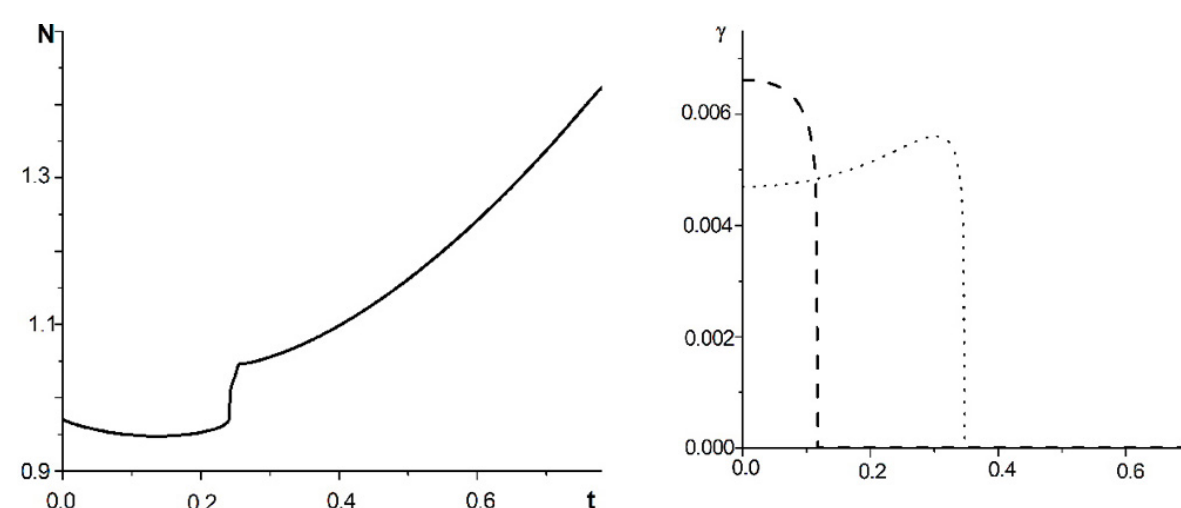
Fig. 9. Growth rates normalized to ω Hfix versus dimensionless time for two wave packets launched at the center of the model cavity with k r = 0 , k θ = 0 and different values of k ϕ . Dashed line corresponds to k ϕ = 0 . 95, and dotted line corresponds to k ϕ = 0 .